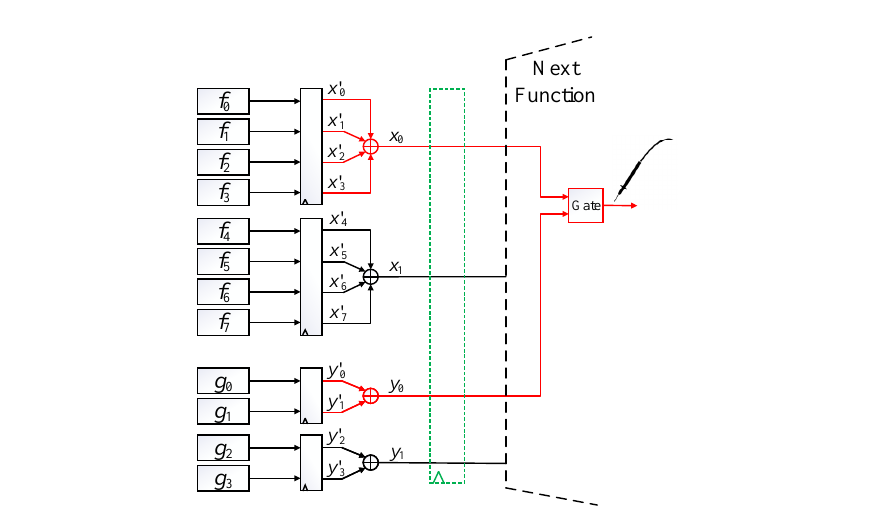
Figure 1: A general block diagram of our constructions.